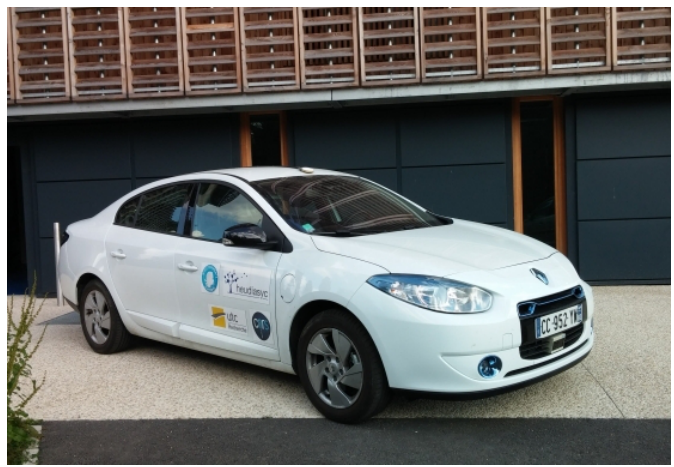
Figure 9. The experimental vehicle.